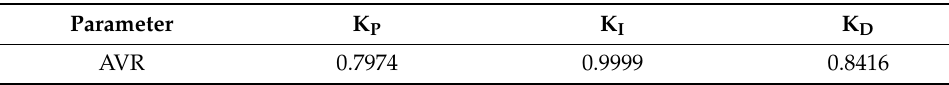
Table 12. Optimized PID controller parameters for AVR.